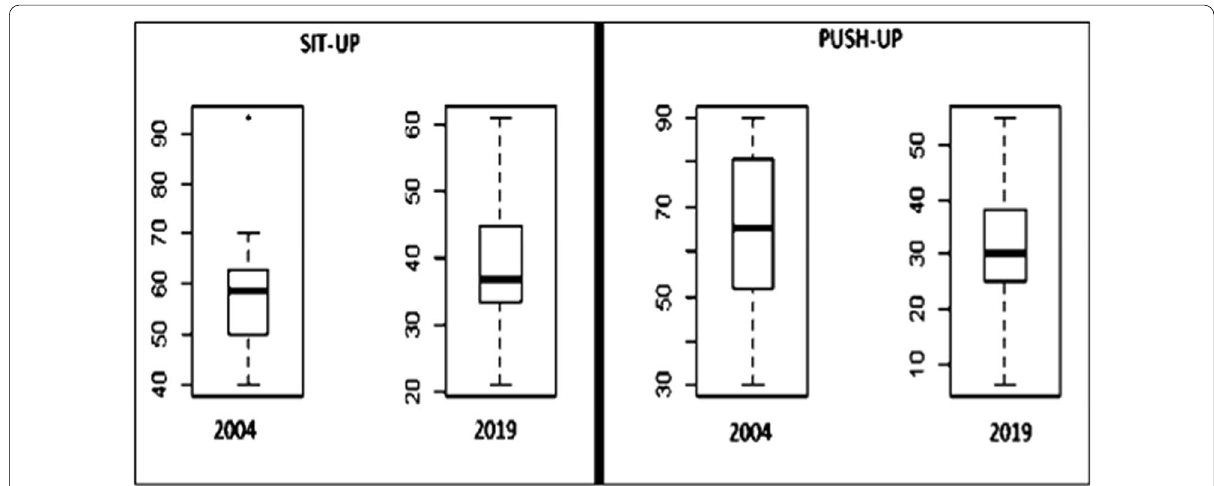
Fig. 1 The changes in sit-up and push-up scores between 2004 and